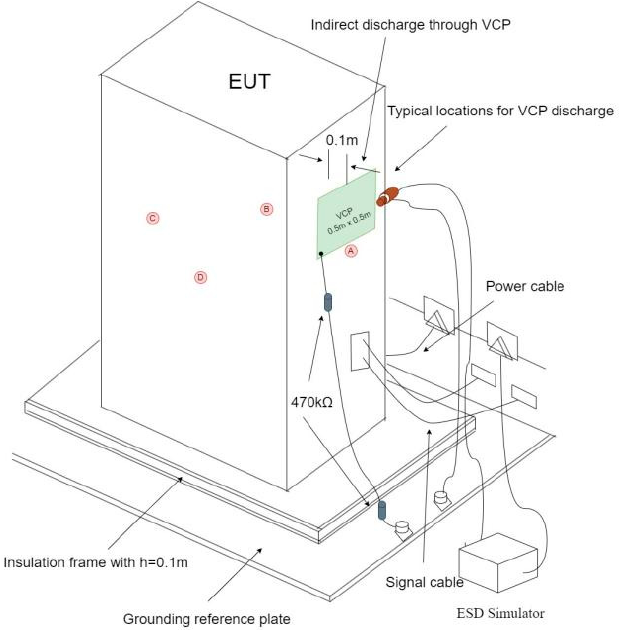
Figure 8. Testing points for vertical coupling plate discharge.